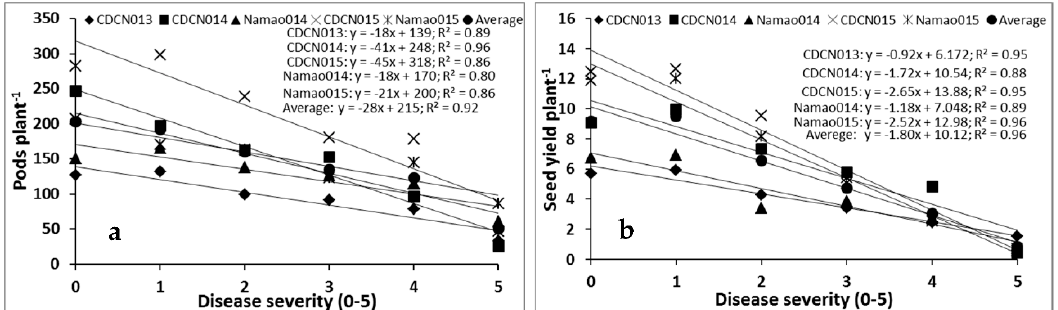
Figure 2. Relationship between blackleg and pods per plant ( a ) and blackleg and seed yield per plant ( b ) in the cultivar “Westar” under field conditions. Data were collected over five site years at two locations in Alberta (Edmonton, 2013–2015 and Namao, 2014 and 2015). Each point represents the mean of four replications × five site-years. Blackleg severity was assessed on a 0–5 scale, where: 0 = no disease and 5 = death of the plant (see text).